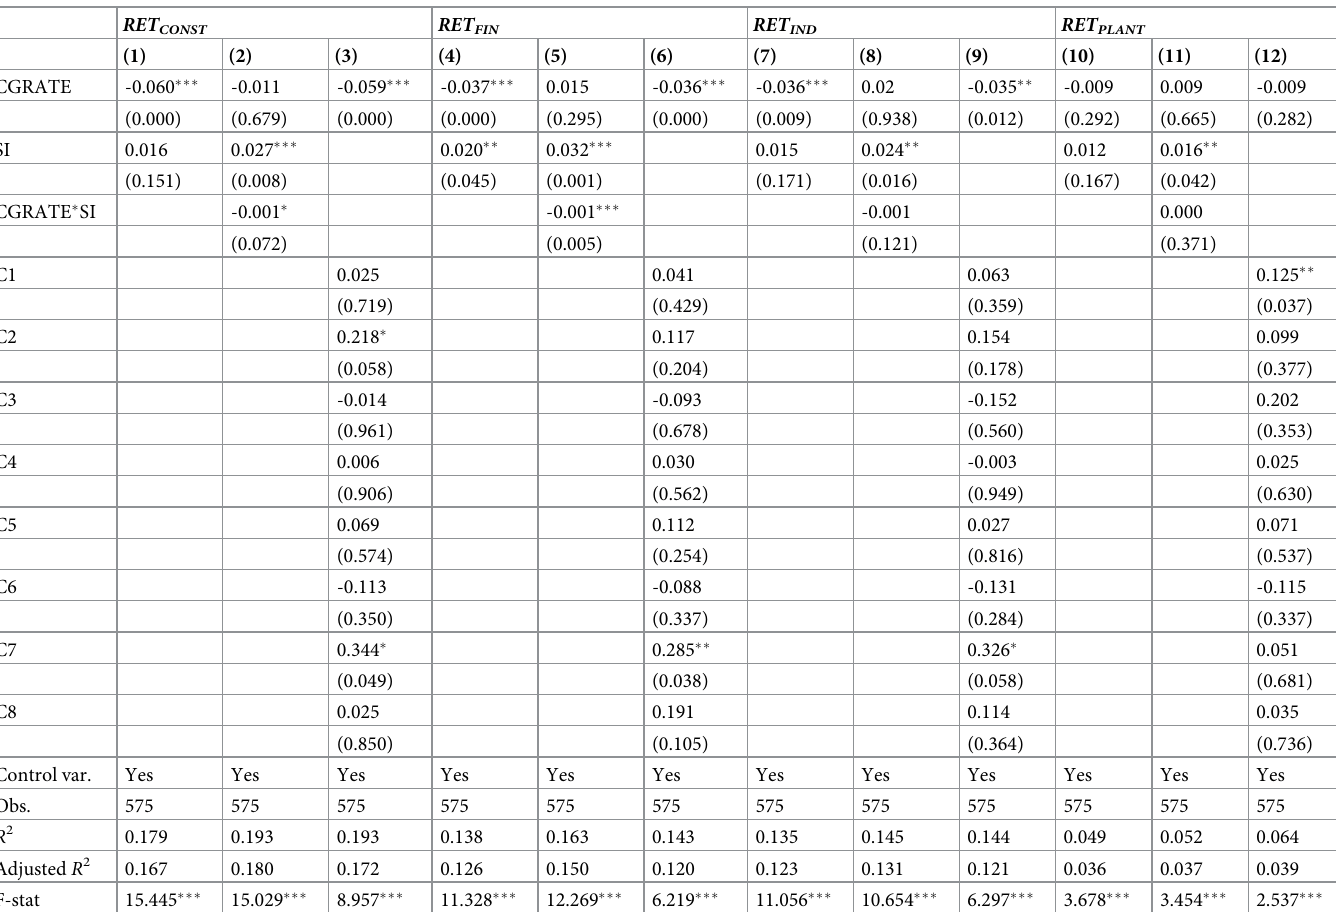
Table 4. Robustness tests: Alternative dependent variables using different sector indices